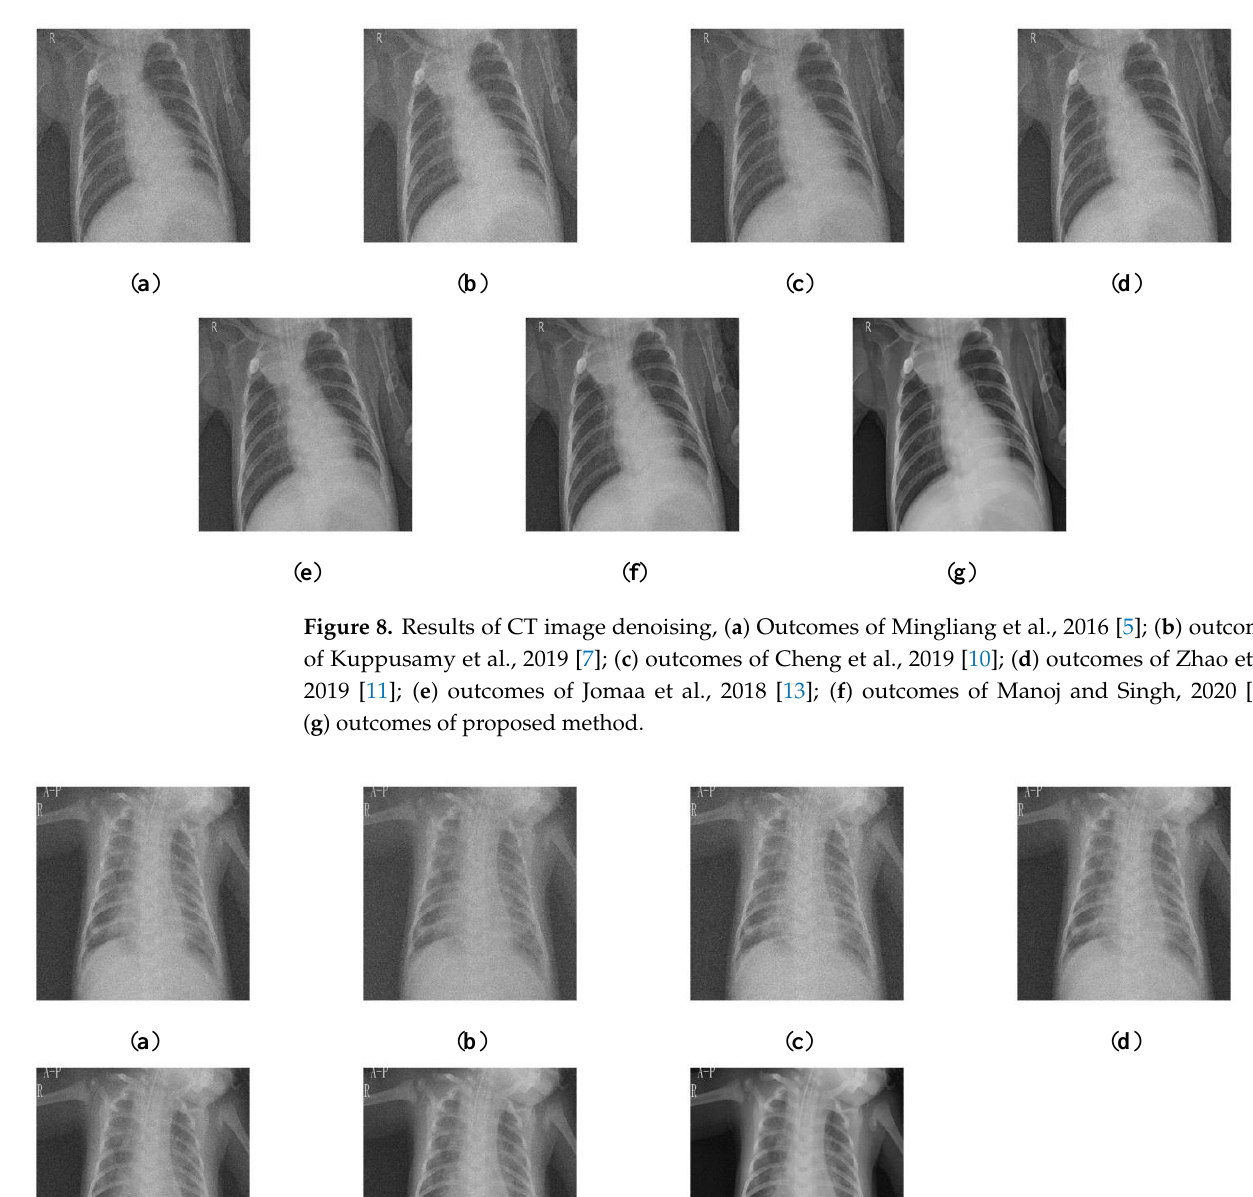
of proposed method.